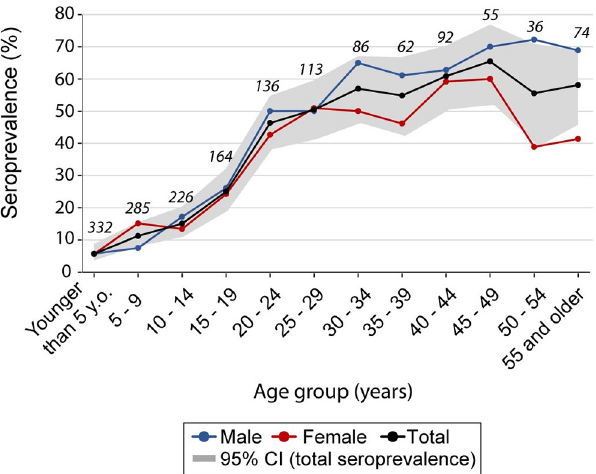
Fig 2. Seroprevalence of T . cruzi infection per 5-year age group and gender for the human population in 2008, prior to a community-wide insecticide spraying campaign, Pampa del Indio, Argentina. The numbers above the lines indicate the total number of people serologically